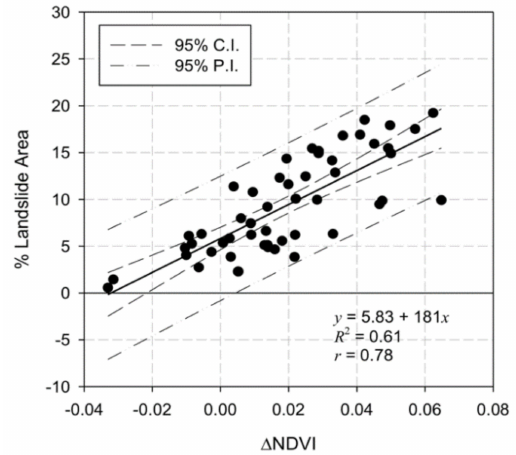
Figure 6. Percent landslide area vs. ∆ NDVI crossplot. The C.I. and P.I. are, respectively, the confidence and prediction